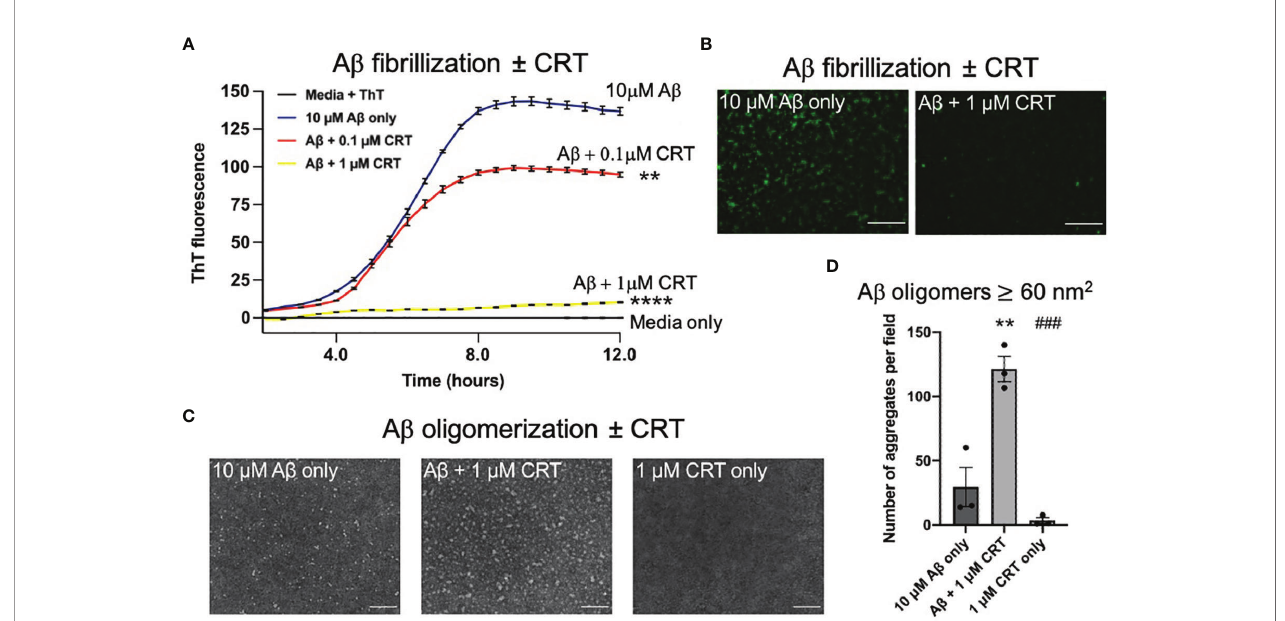
FIGURE 6 | Calreticulin prevents fi brilization and promotes formation of large oligomeric structures of amyloid beta. (A) 10 m M of monomeric A b was incubated at 31.5°C in DMEM with 10 m M thio fl avin T ± 0.1 m M or 1 m M calreticulin (CRT), and the fl uorescence recorded over time. (B) At the end of the assay, each well was imaged using a fl uorescence microscope. Scale bar = 50 m m. (C) 10 m M of monomeric A b was incubated for 18 h at 4°C ± 1 m M CRT to generate A b oligomers imaged by transmission electron microscopy. Representative images shown. Scale bar = 100 nm. (D) Quanti fi cation of aggregate ≥ 60 (nm 2 ) quanti fi ed from (C) . Data presented as mean fi nal fl uorescence or average aggregate size values, with error bars representing the SEM of at least 3 independent experiments. Statistical comparisons were made by one-way ANOVA. Asterisk (*) indicate signi fi cance (**p<0.01, ****p<0.0001) to 10 m M A b only. Hash (#) indicate signi fi cance ( ### p<0.001) to 10 m M A b + 1 m M